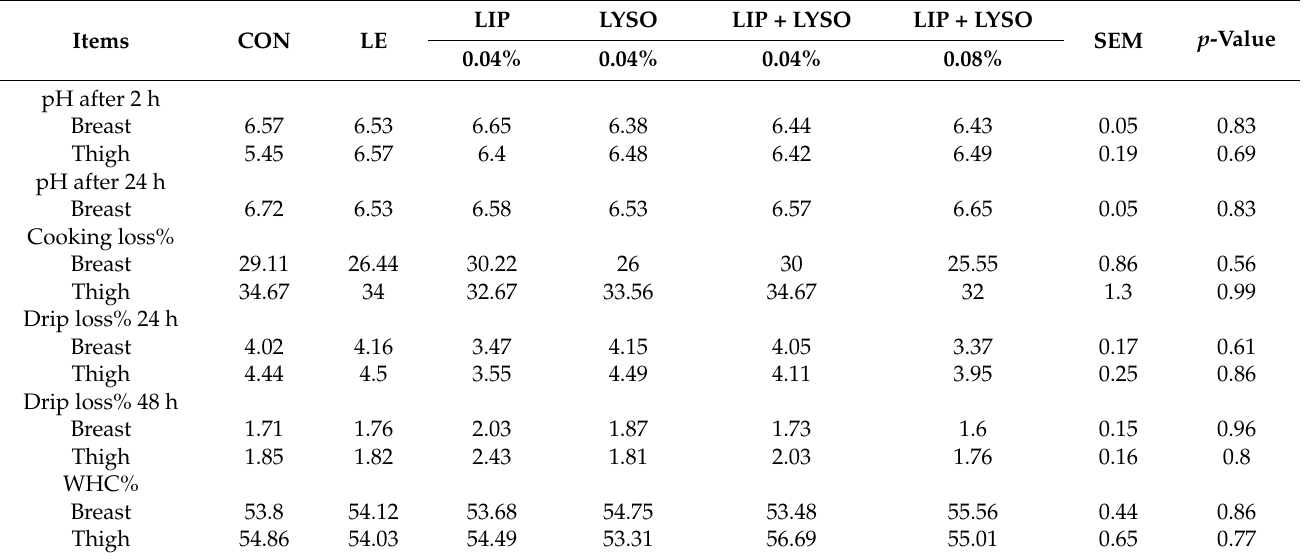
Table 5. Effect of low energy diet and supplementation of emulsifier and lipase on meat quality in broilers.